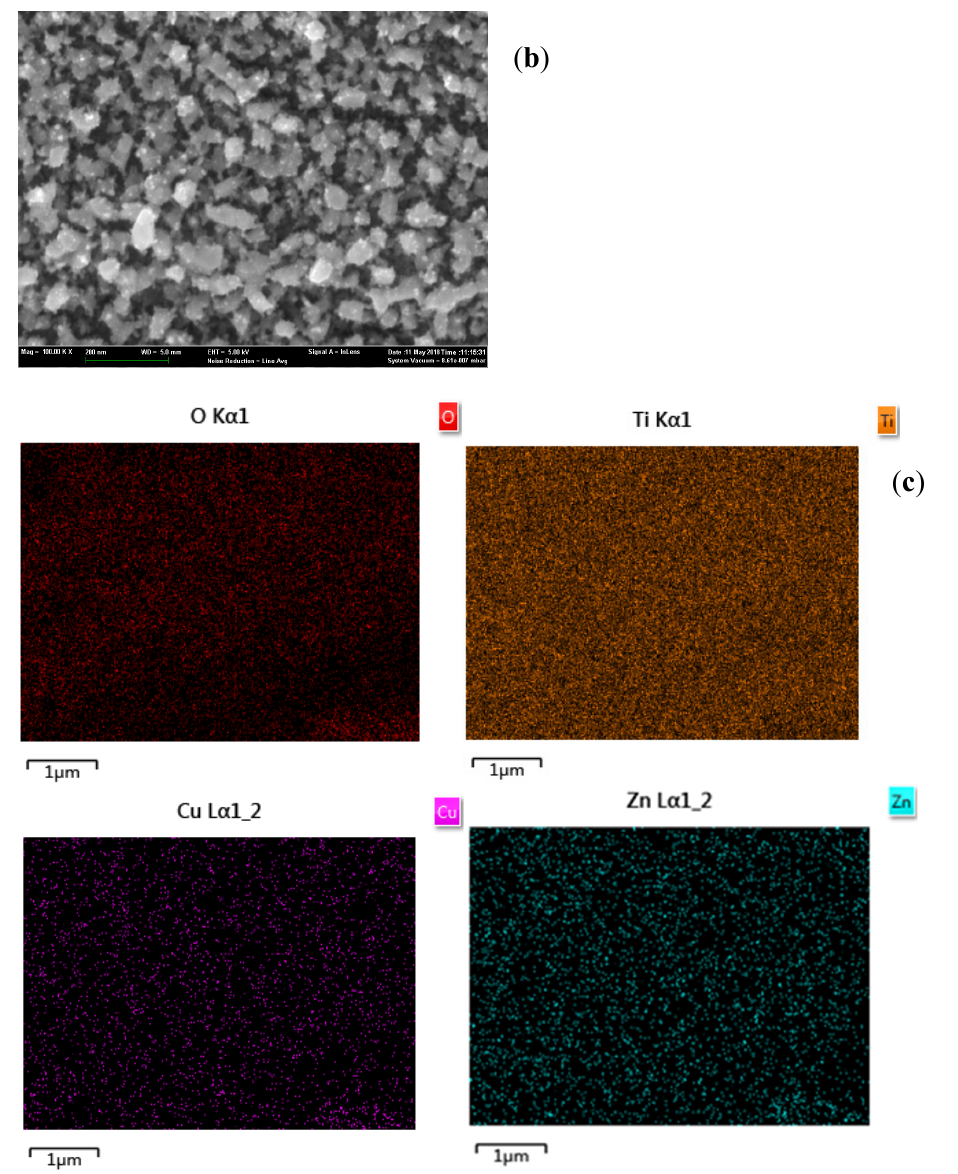
Figure 3. Characterization of the Zn-Cu-TiO 2 polymetallic nanoelectrode in terms of its ( a ) surface morphology, ( b ) distribution of elements, and ( c ) distributions of individual elements.